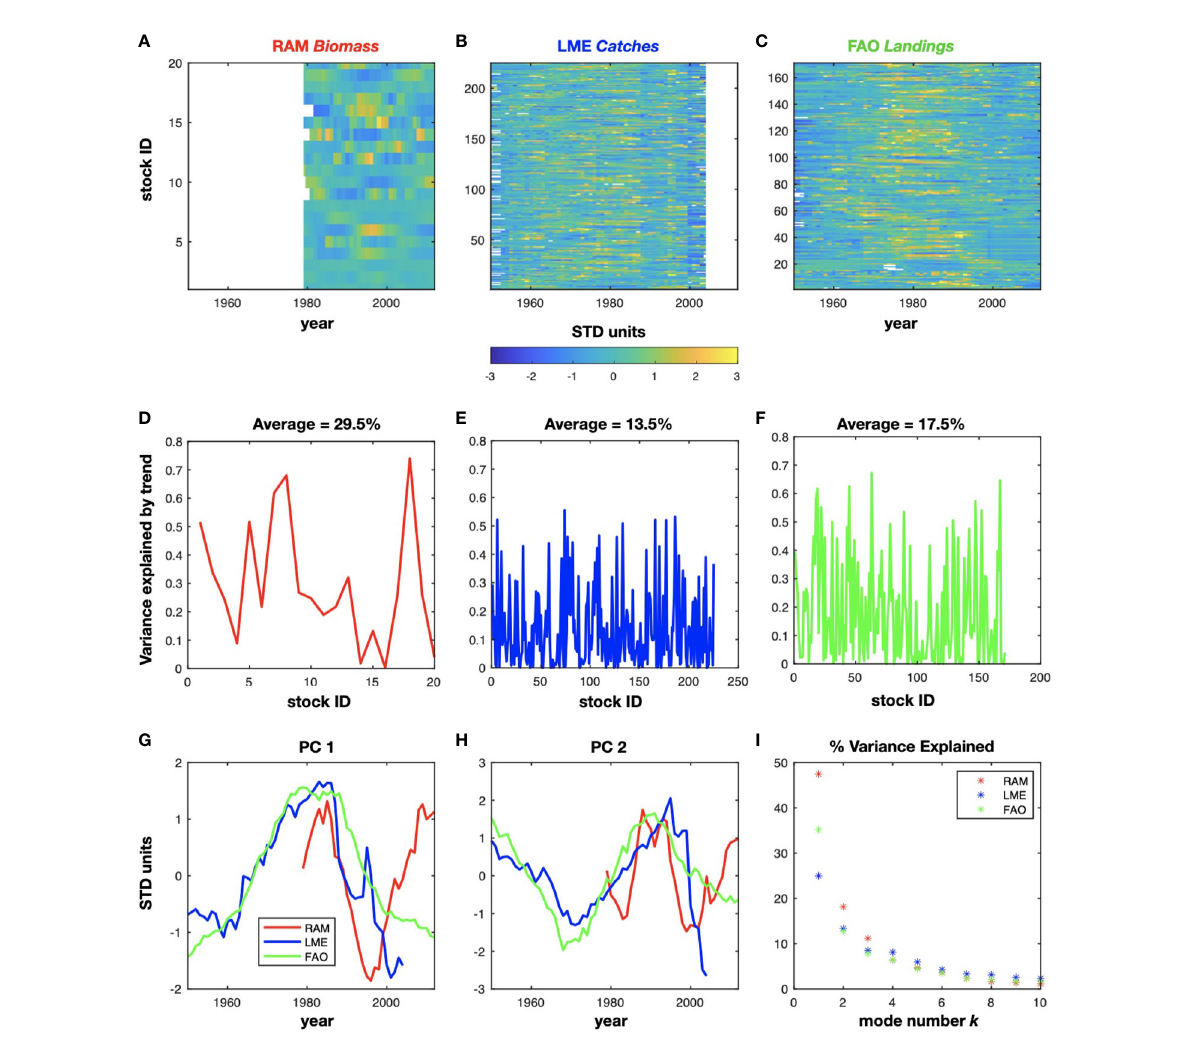
FIGURE 1 Timeseries of detrended and normalized fi sh stocks for the RAM (A) , LME (B) , and FAO (C) datasets. The variance explained by the removed trend is represented in (D, E) , and (F) . The mean variance excluded by the detrending has been inserted in the plots. The associated variability is described by the fi rst and second principal component (G) and (H) , while the corresponding EOFs are displayed in Supplementary Figure S1. The percentage of variance explained by the PCs in each dataset is shown in (I)